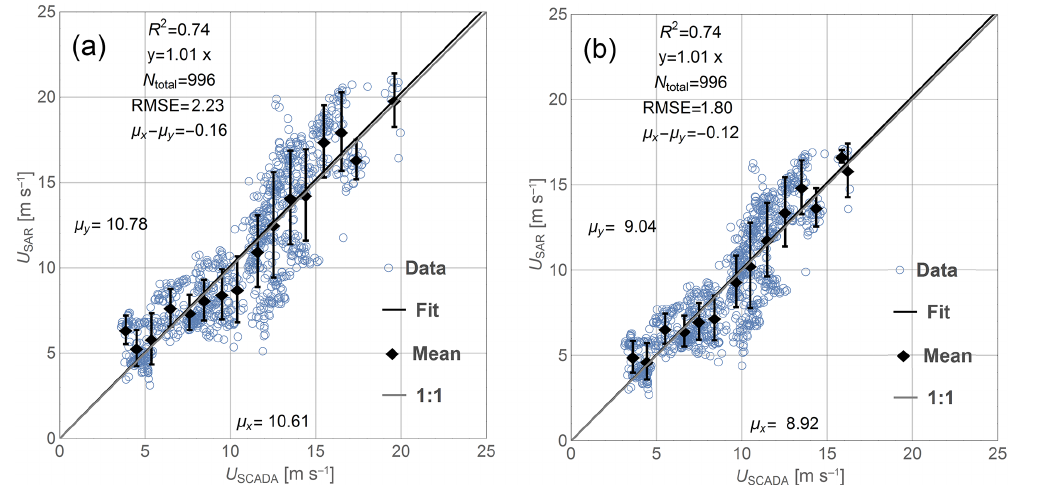
Figure 4. Comparison between SCADA-derived wind speeds ( U SCADA ) and SAR-derived wind speeds ( U SAR ) upstream of the wind turbines: (a) for the turbine hub height (81.6m) and (b) for the reference height (10m).